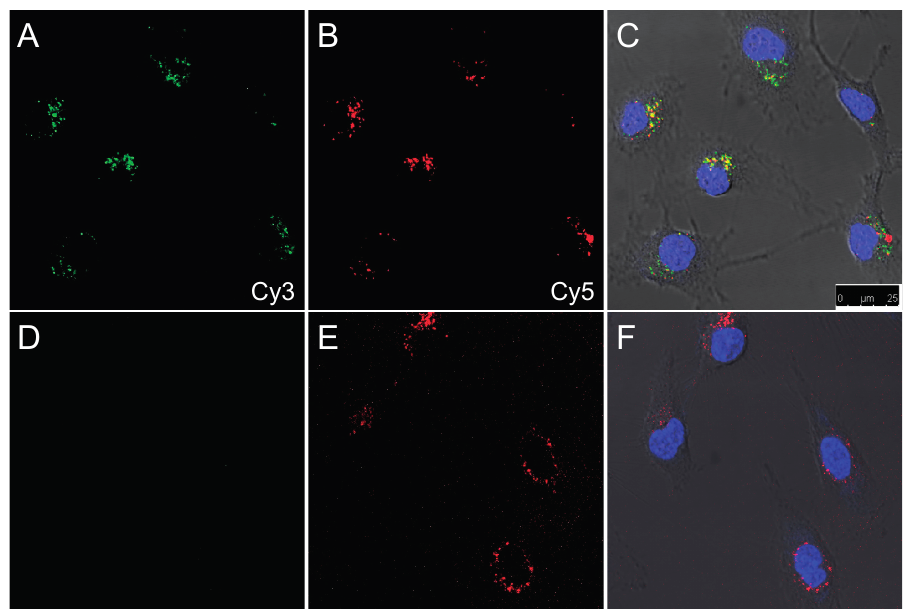
Figure 4. Confocal images of SKOV-3 cells after 24 h incubation with 2L ( A – C ) or 2D ( D – F ). ( A , D ) Cy3 channel in green; ( B , E ) Cy5 channel in red; ( D , F ) Overlay of differential interference contrast, nuclear stain (Hoechst 33342, blue), Cy3 (green), and Cy5 (red). Excitation and emission wavelengths are described in the Experimental Section.